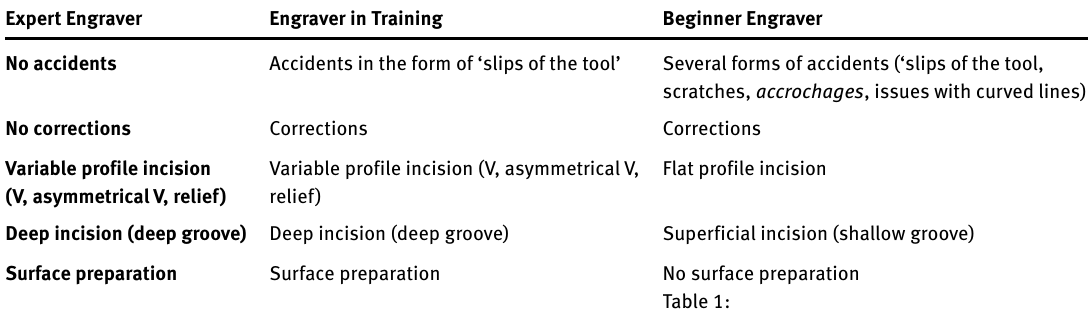
Table 1. Characteristics associated with different degrees of expertise among Magdalenian engravers (elaborated from Rivero, 2015, p.